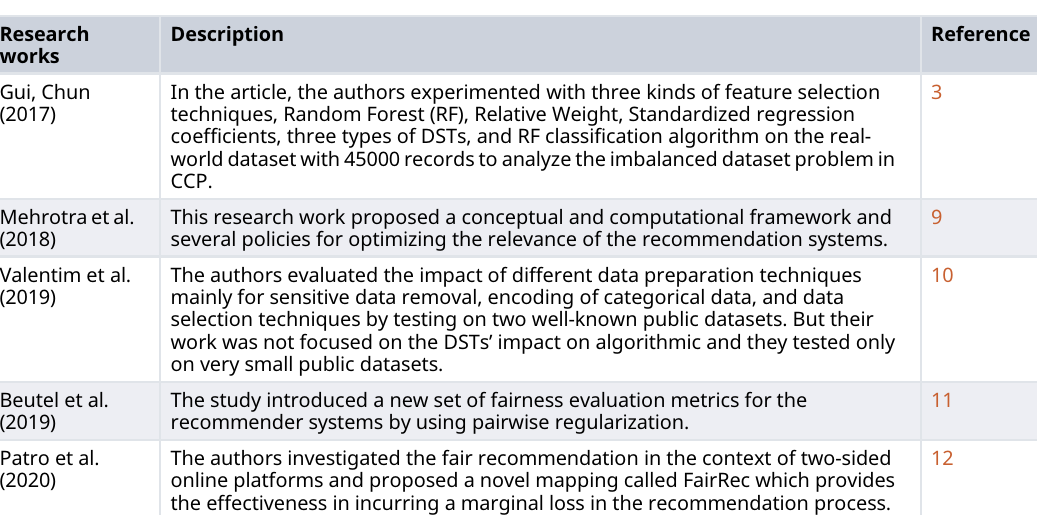
Table 1. Description of related